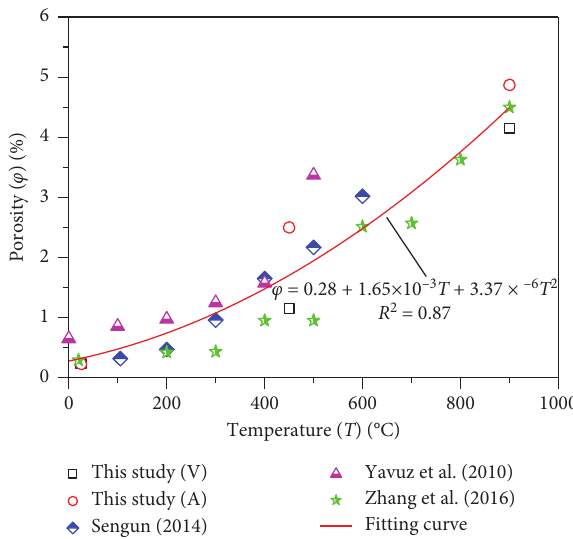
Figure 11: Effect of temperature on the porosity of limestone.